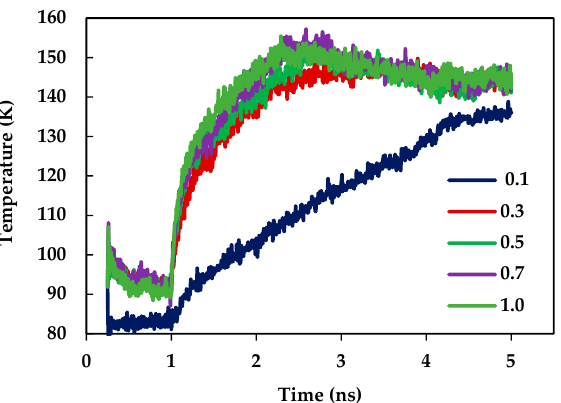
Figure 7. Temperature history of argon atoms for different surface wetting conditions.